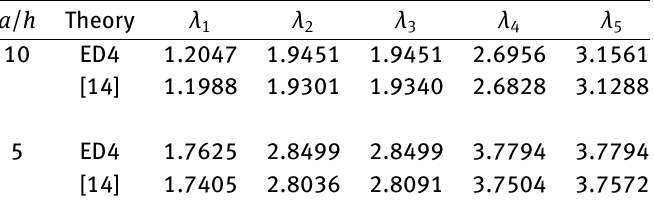
Table 2: Non-dimensional frequency parameters λ = ωa